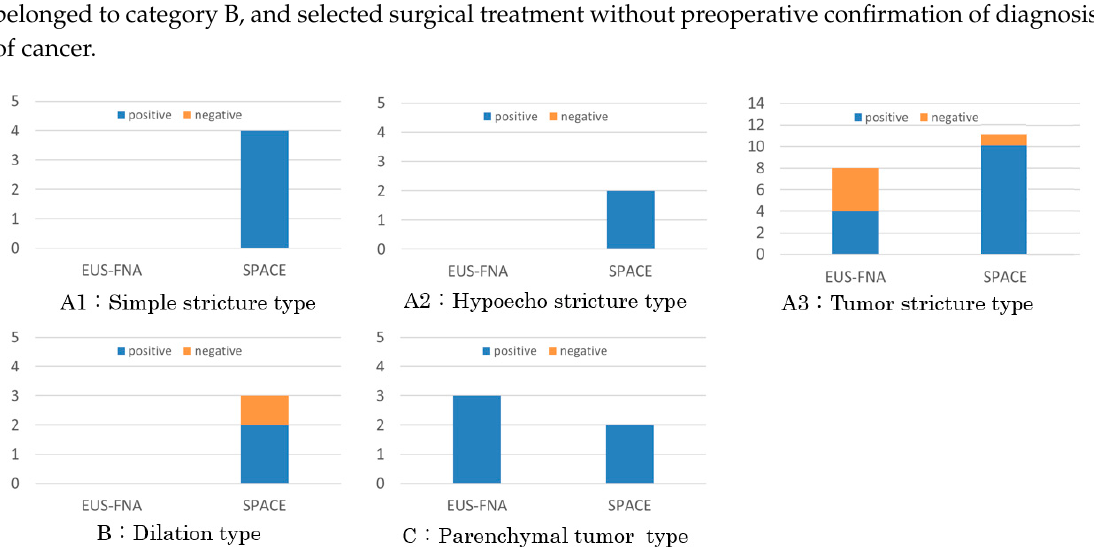
Figure 10. Preoperative diagnostic procedures. Serial pancreatic-juice aspiration cytologic examination (SPACE) was selected for not only patients in categories ( A1 ), ( A2 ), and ( B ), without an apparent tumor, but also in categories ( A3 ), and ( C ), with a recognized tumor, and sensitivity of SPACE was 92.0%, while EUS-guided fine needle aspiration cytology (EUS-FNA) was used for patient in categories (A3), and (C), and sensitivity was 66.7%.